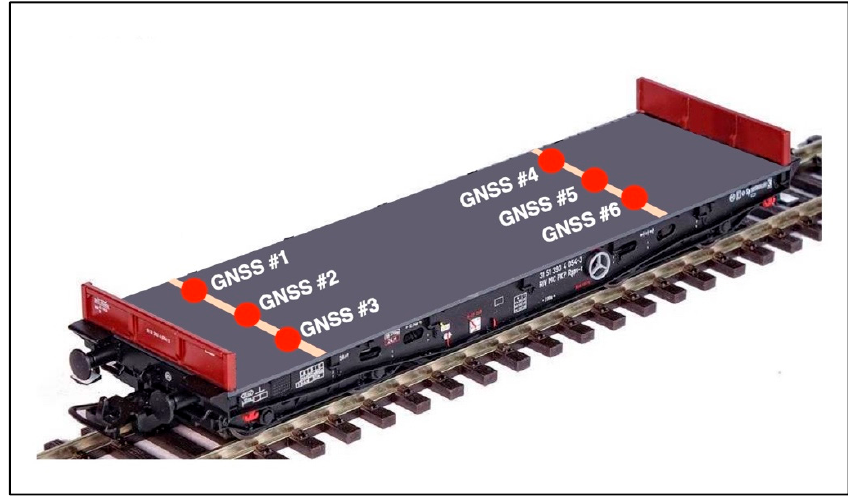
Figure 5. The position of GNSS receivers on the mobile surveying platform. Table 2. Coordinates of GNSS receiver antennas along with the errors of their determination, obtained from satellite observations.